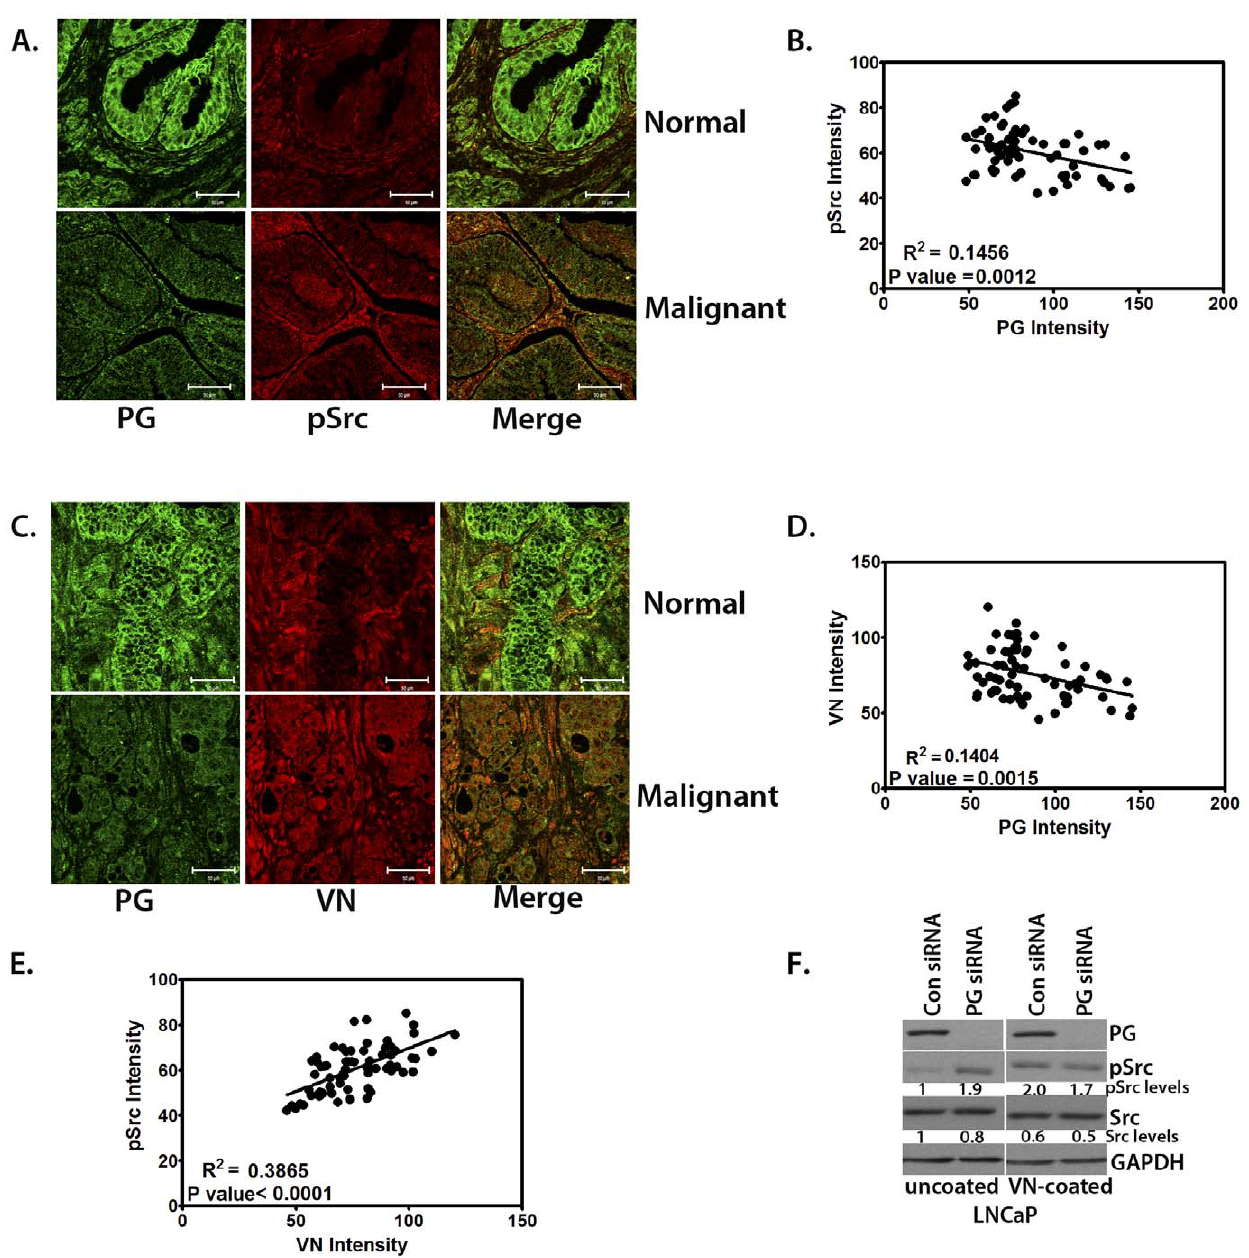
Figure 7. PG-dependent Src activity is regulated by VN. A. Confocal images showing PG and pSrc expression in normal and malignant prostate tissue (using 68 cores from the prostate TMA). PG is in green and pSrc is red. Bar, 50 m m. B. Scatterplot demonstrating the inverse correlation between pSrc expression and PG expression in prostate tissue (using 68 cores). C. Confocal images showing PG and VN expression in normal and malignant tissue (T2 samples were shown for both pSrc and VN as representative of average expression levels in all malignant tissue samples). PG is in green and VN is red. Bar, 50 m m. D. Scatterplot showing the inverse correlation between VN expression and PG expression in prostate tissue (using 68 cores). E. Scatterplot showing the direct correlation between VN expression and pSrc in prostate tissue (using 68 cores). F. Western blot showing PG, pSrc, and Src expression in LNCaP cells transfected with control or PG siRNA plated on uncoated or VN-coated plastic. VN rescues Src activation in the absence of PG.